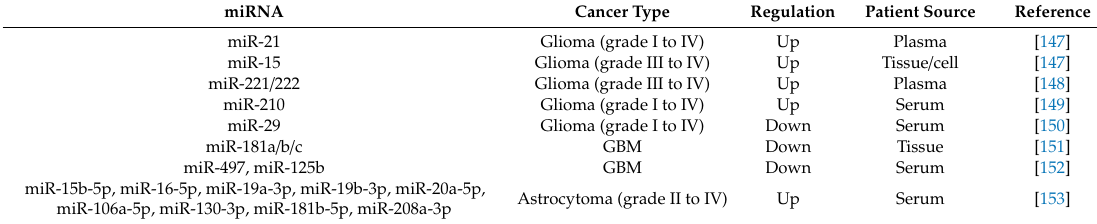
Table 3. Deregulated miRNAs from di ff erent sample types as potential diagnostic biomarker in glioma. miRNA Cancer